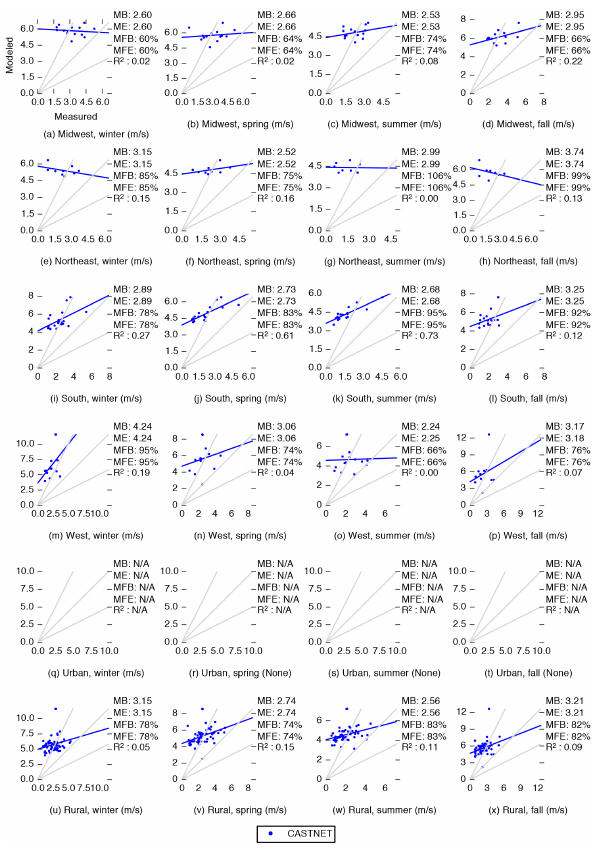
Figure A3. Comparison of modeled and measured temperature, dis- aggregated by region and